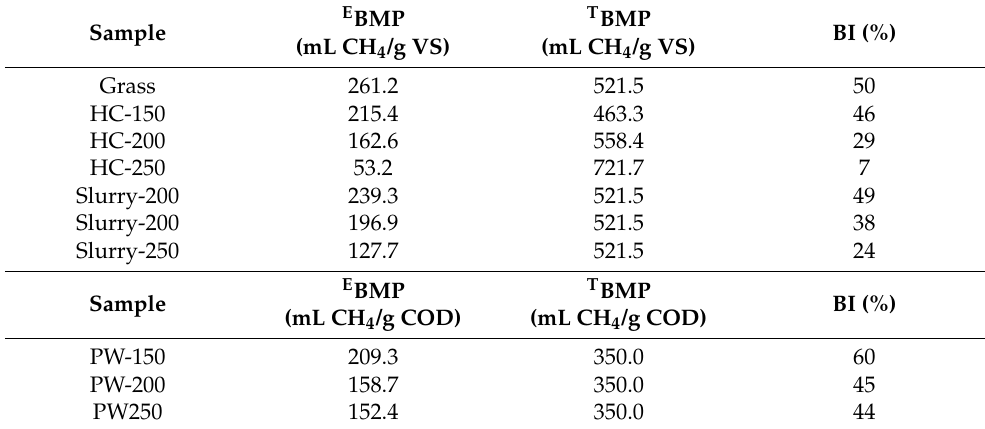
Table 6. Biodegradability index (BI) of grass and HTC